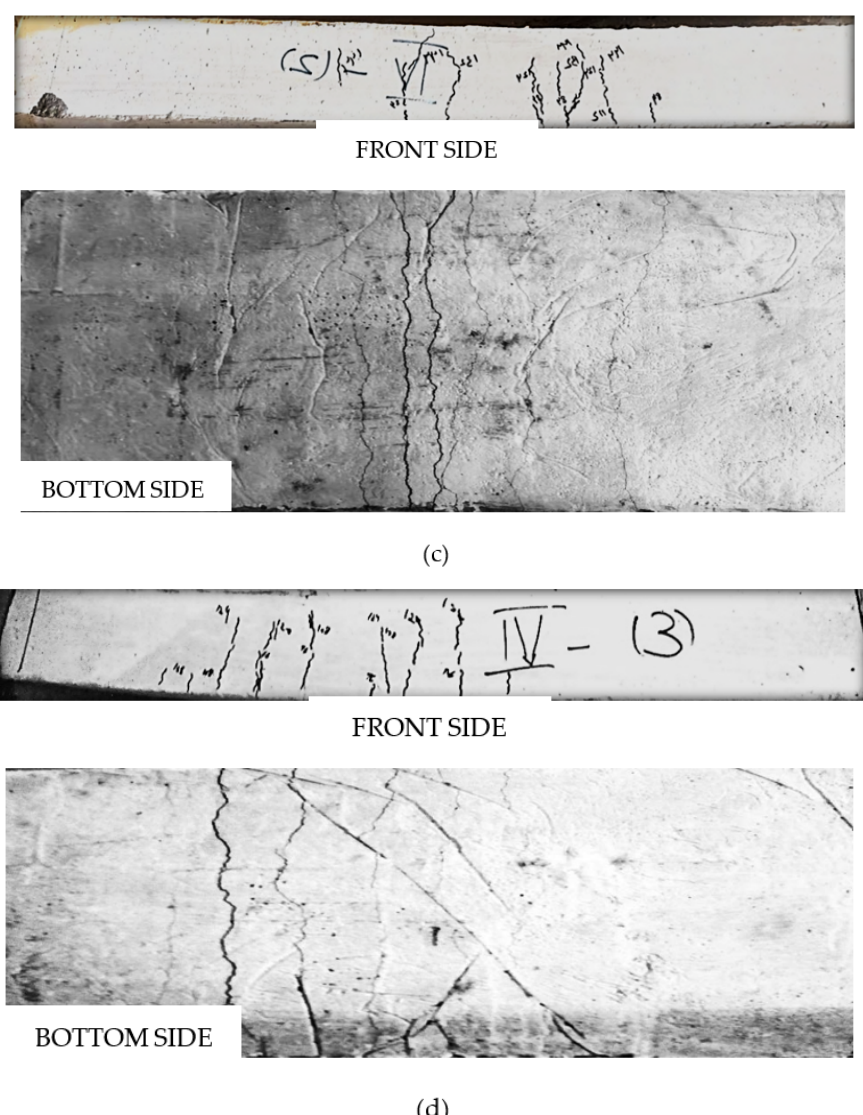
Figure 22. Typical crack pattern of control slab and ferrocement slabs with equivalent steel area (four steel wire mesh). ( a ) Crack pattern of CS, concrete control slab. ( b ) Crack pattern of F4A1MPPF-S slab (0.1% PPF), 0.1% of PPF percentage. ( c ) Crack pattern of F4B1MPPF-S slab (0.3% PPF), 0.3% of PPF percentage. ( d ) Crack pattern of F4C1MPPF-S slab (0.5% PPF), 0.5% of PPF